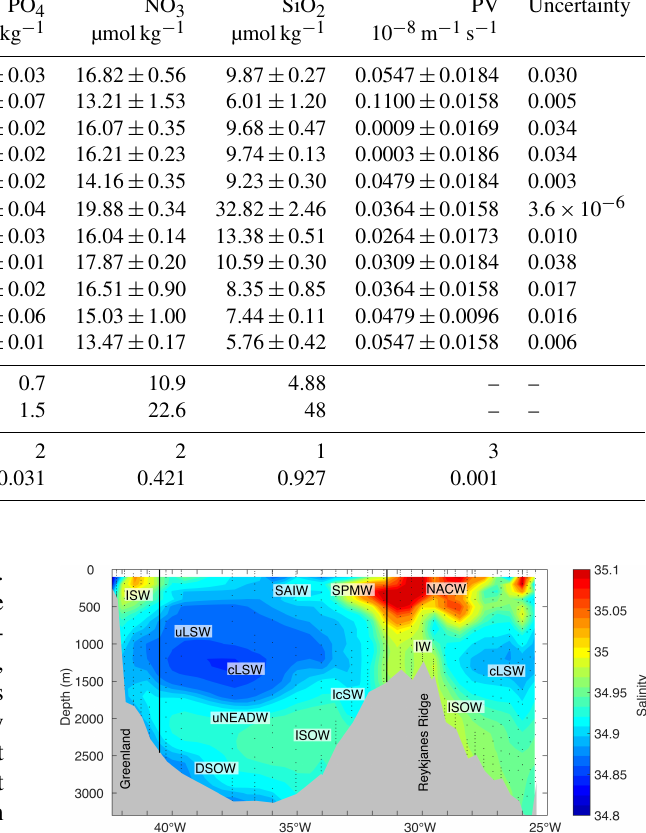
The Icelandic Slope Water (IcSW), the Intermediate Wa- ter (IW), the Irminger Sea Water (ISW) and the uLSW are typically found at intermediate depths. IcSW is a warm and saline water mass close the Reykjanes Ridge on the Ice- land slope (Tanhua et al., 2005; Yashayaev et al.,